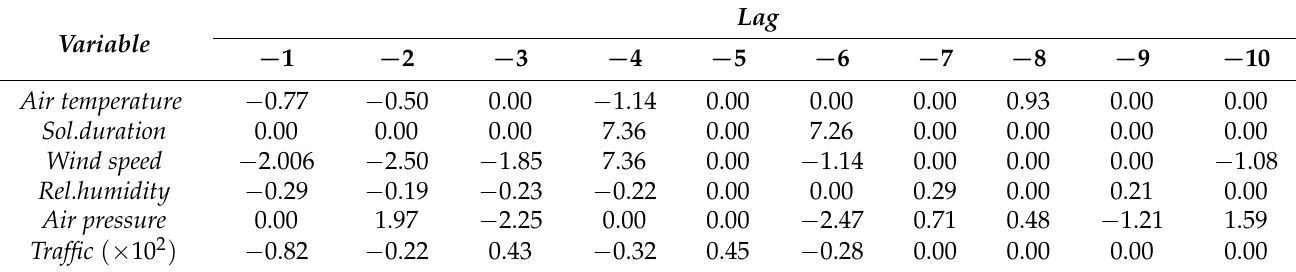
Table 5. Test results, lagged data: coefficients for the linear regression,